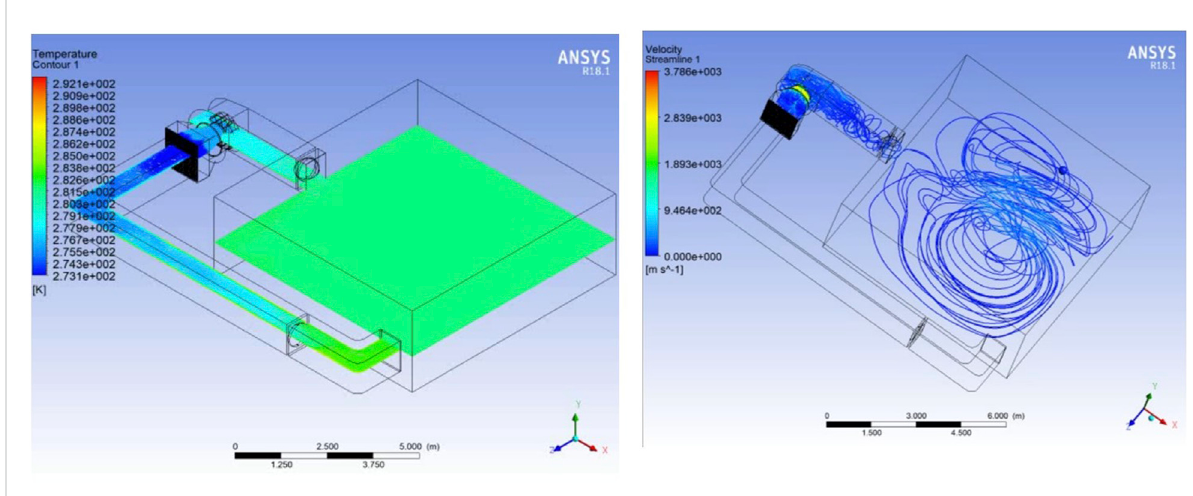
FIGURE 2 Temperature and fl ow velocity distribution of the room area through ANSYS Fluent